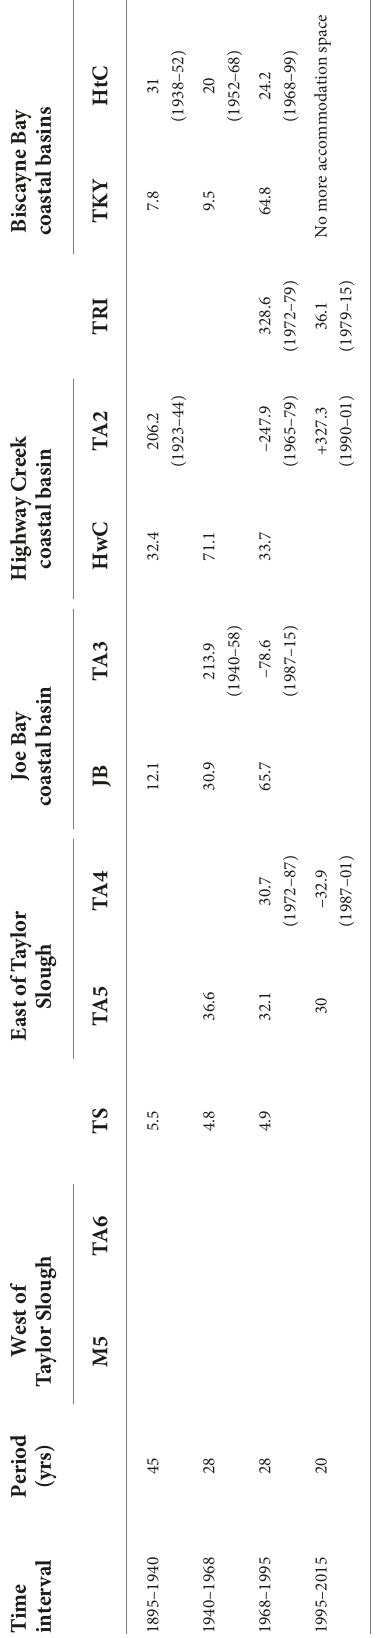
by submerging mangrove and intertidal followed by subtidal